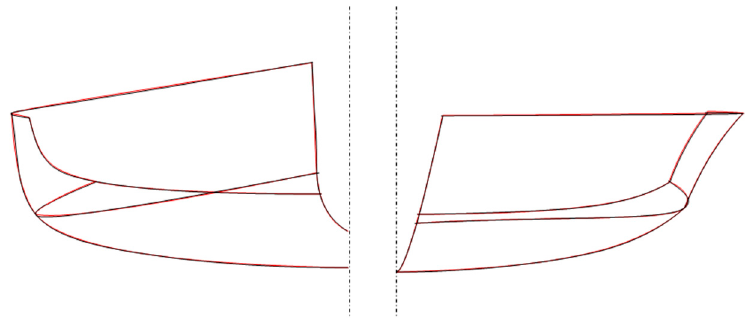
Figure 16. Lines of the original hulls (black) and rebuilt ones (red). LED on the left part and TryAgain on the right (part).